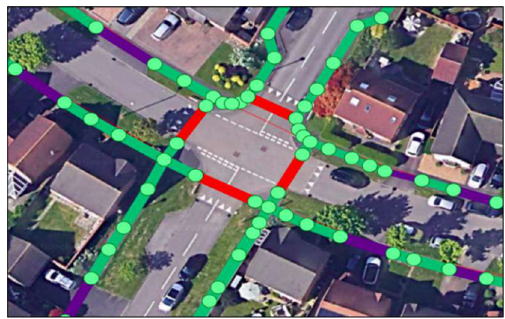
Figure 2. Preliminary map for robots